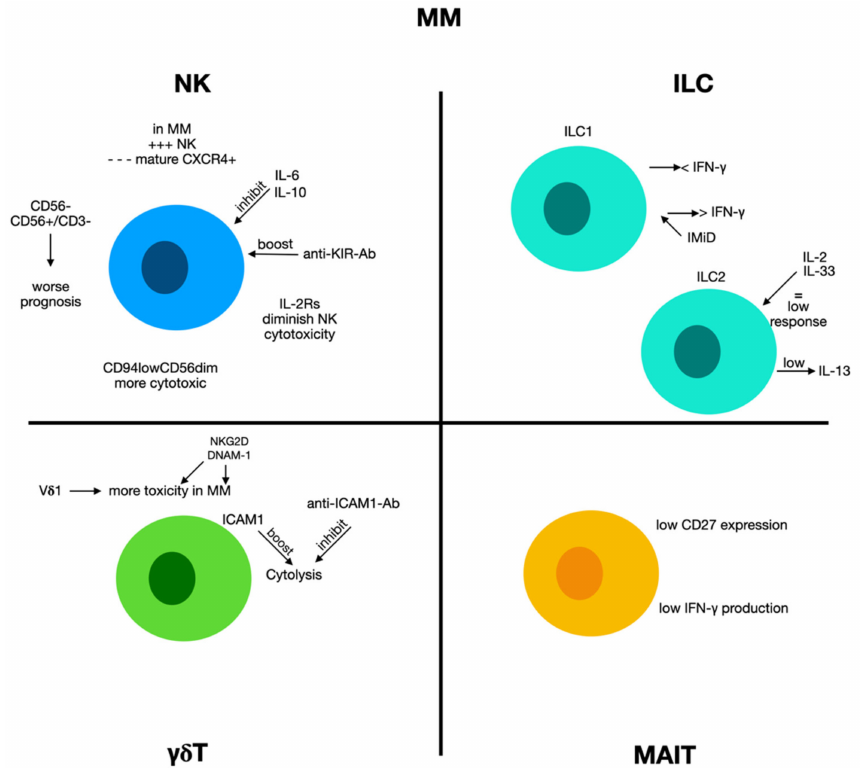
Figure 5. Multiple myeloma (MM) unconventional immune cell scenario. NK: MM subjects present- ing a more significant number of NK cells at the onset of disease had a severer prognosis, leading to the unproductive stimulation of the immune system. Patients augmented with NK cells were concomitant with a less mature CXCR4+ NK cell subset. The presence of CD56+ CD3 − NK cells of CD56- was related to a worse prognosis. IL-6 and IL-10 participate in NK cell functional alteration. Anti-KIR antibodies stimulated antineoplastic NK toxicity, as well as soluble IL-2 receptor. ILC: IFN- γ decreased in MM. The administration of IMiDs such as pomalidomide re-establishes the production of IFN- γ by ILC1s. ILC2s showed a weak ability to produce IL13 and an inadequate response to IL-2/IL-33 stimulation. γδ T: IFN- γ secretion and V δ 1 T cell toxicity against MM cells occurred due to the T cell receptor (TCR) and other molecules (such as NKG2D, CD3, and CD2 receptors), DNAX accessory molecule-1, and intracellular cell adhesion molecule (ICAM)-1. MAIT presented low CD27 expression as well as low IFN- γ